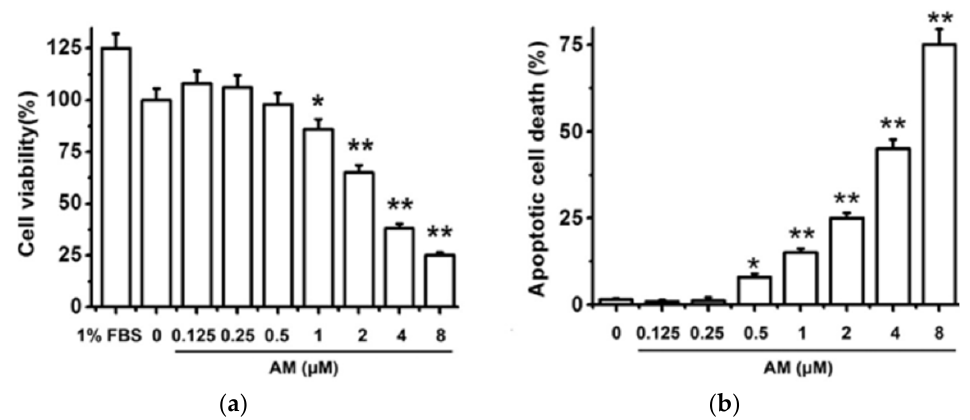
Figure 5. Amiodarone (AM) decreases cell viability and increases apoptosis in a concentration- dependent manner. ( a ) RGCs were treated with amiodarone and measured for cell viability using an MTT assay at 24 h. ( b ) Cellular apoptosis was determined using Hoechst 33342 staining at 24 h. The data are expressed as the mean ± SEM of results obtained from five independent experiments. * p < 0.05, ** p < 0.01 [40].